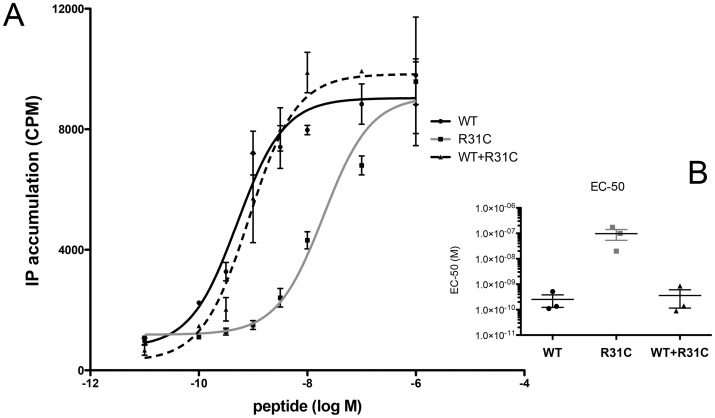
IP accumulation.(A) COS-7 cells were transiently transfected with human GnRH-R expression vector and washed before the addition of myo-[2-3H]Inositol. After 16 hours cells were washed and incubated for 1 hour with graded concentrations of WT, R31C and equimolar WT+R31C GnRH. This experience was conducted three times each in triplicate. (B) Representation of individual values of EC-50 (calculated with Arcsin “P” root transformation) from n = 3 dose-response experiments. WT GnRH EC-50 was calculated at 0.52±0.22 nM, R31C EC-50 at 198.8±75.9 nM, WT+R31C EC-50 at 0.63±0.42 nM.